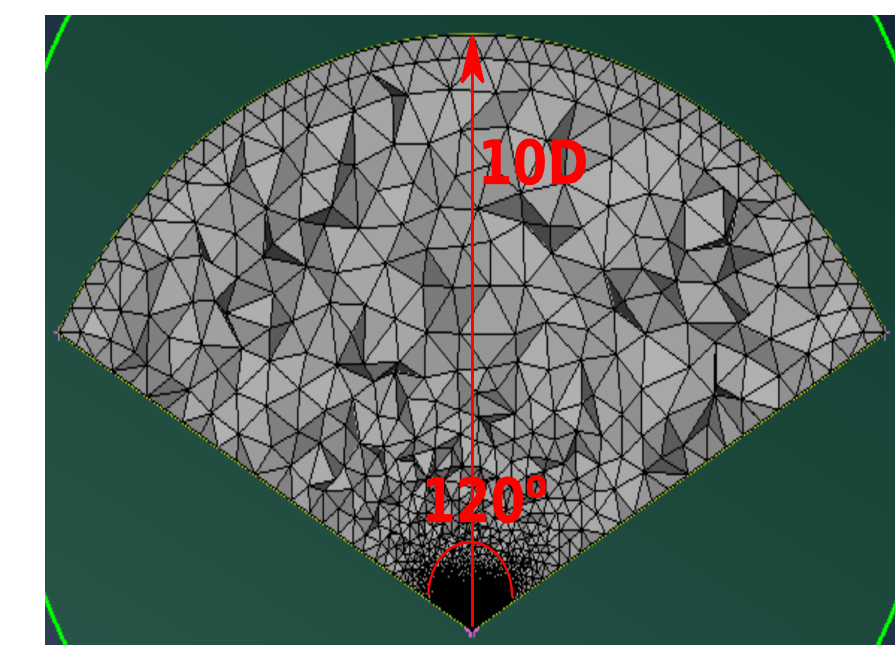
Figure 4. Periodic grid. Axial